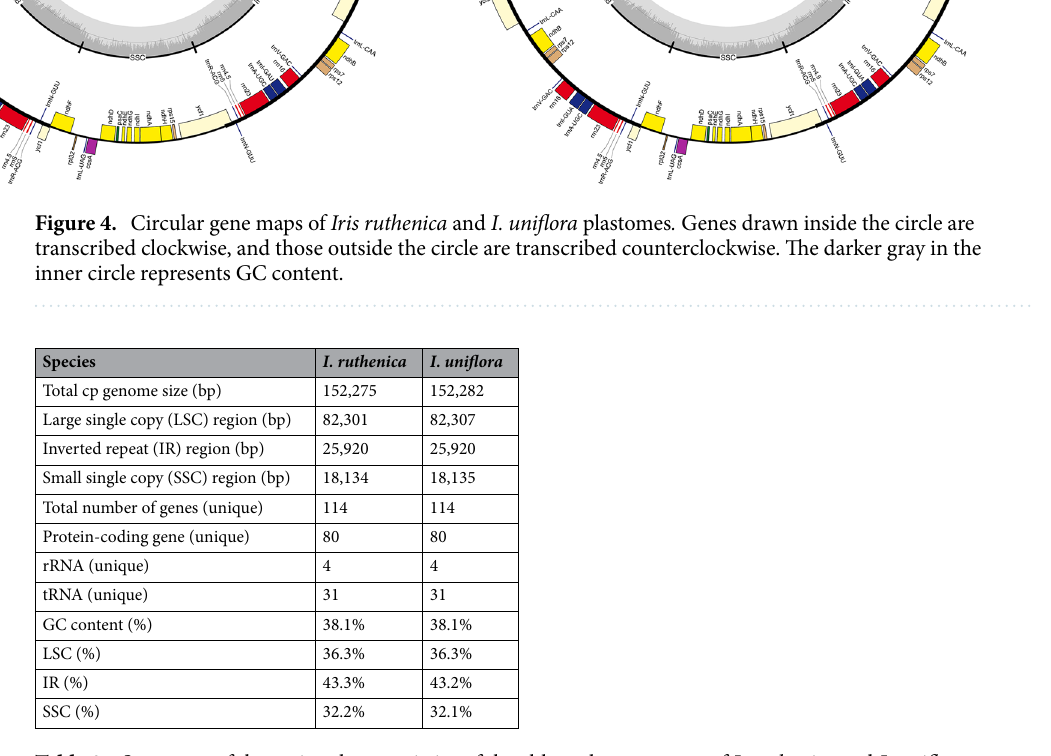
Table 3. Summary of the major characteristics of the chloroplast genomes of I. ruthenica and I. uniflora .